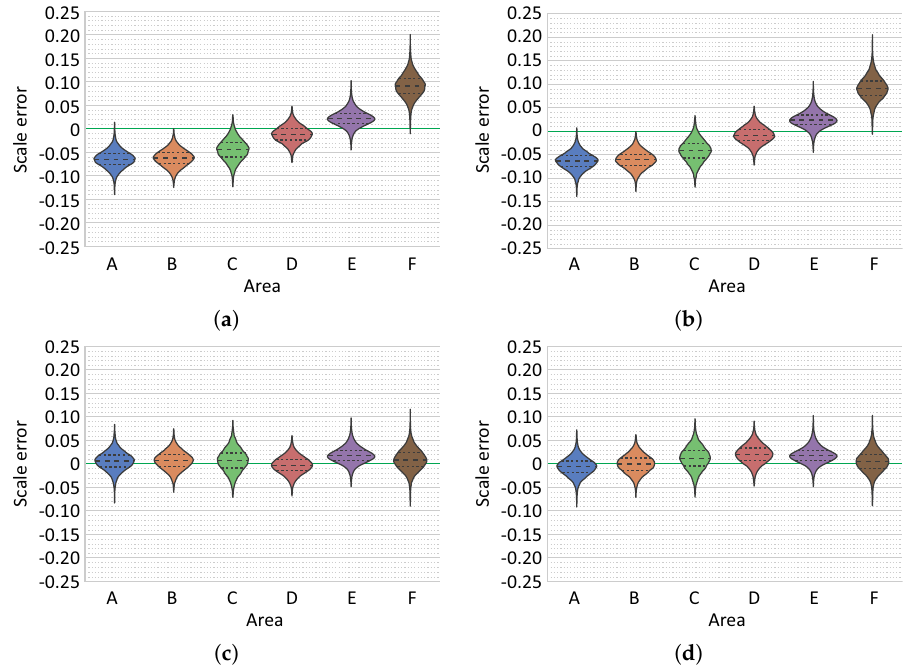
Figure 25. Estimated scale errors per segment for model AUTT28: ( a / b ) Global/Incremental SfM with similarity transformation navigation fusion. ( c / d ) Global/Incremental SfM with multiobjective BA navigation